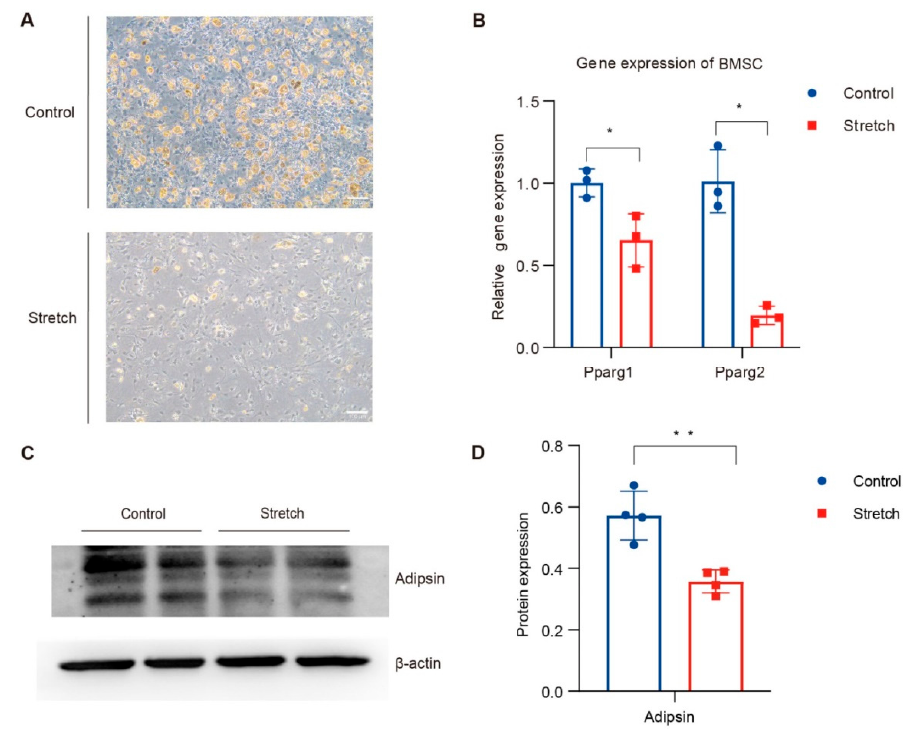
Figure 4. Exercise inhibited adipogenic differentiation of BMSCs and decreased adipsin in vitro. Isolated tibia mesenchymal stem cells were divided into control group and stretch group during adipogenic differentiation ( N = 3). ( A ) representative images of control and stretch groups under a 10× phase-contrast microscope at the end of adipogenic differentiation. ( B ) quantitative PCR analysis of adipogenic relative gene expression in the BMSCs, containing Pparg1 and Pparg2. ( C , D ) representative Western blotting images and protein expression quantification ( N = 4) of adipsin from mesenchymal stem cells treated with adipogenic differentiation and stretch stimulation. * p < 0.05, ** p < 0.01 for control group vs stretch group. Two-sided Student t-tests were used for statistical analyses. Data are presented as the mean ± SD. BMSCs, bone mesenchymal stem cells.